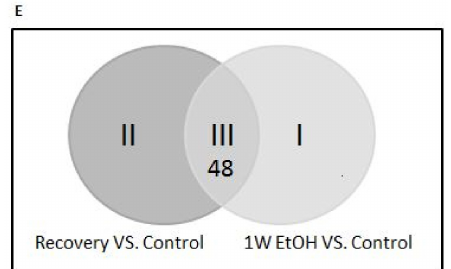
Figure 6. Functional analysis of gene expression in response to EtOH treatment and the recovery from EtOH insult. Cells were exposed to 25 mM EtOH for one week and the expression of their gene expressions was analyzed by microarrays hybridization. Function analysis was done by the DAVID algorithm. ( A ) 25 mM EtOH treatment of one week (78 genes). ( B ) Recovery treatment (207